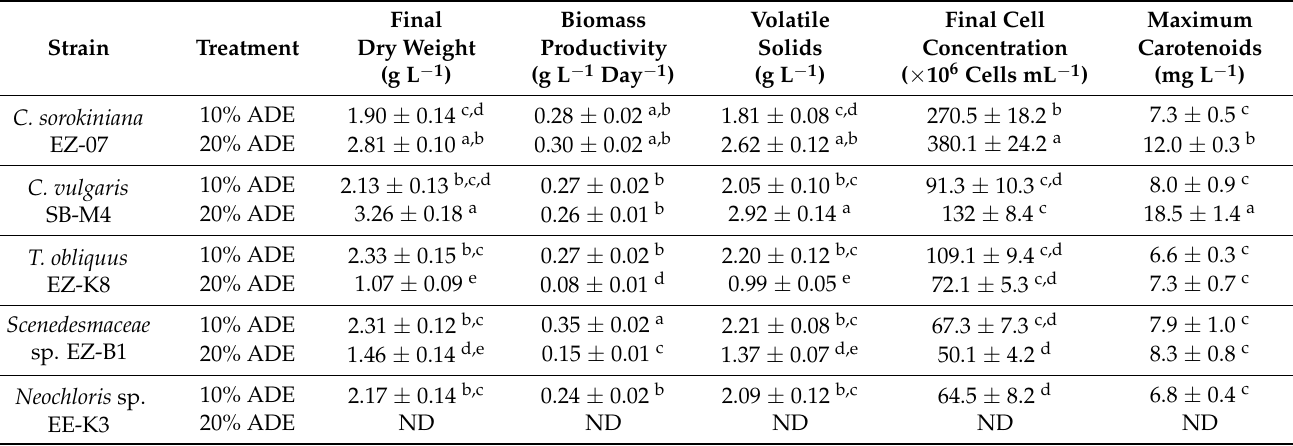
Table 2. Characteristics of tested microalgal strains when grown in ADE-based